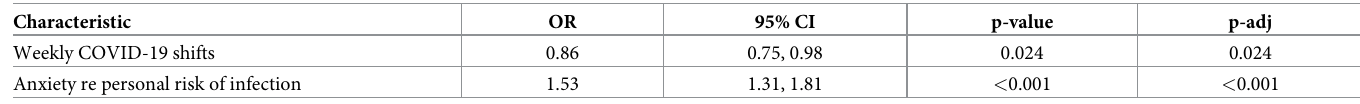
Table 2. Results of multivariate logistic regression analysis of factors predicting clinically-relevant psychosocial distress (GHQ-12 � 3). Characteristic OR 95% CI p-value p-adj Weekly COVID-19 shifts 0.86 0.75, 0.98 0.024 0.024 Anxiety re personal risk of infection 1.53 1.31, 1.81 < 0.001 < 0.001 OR = odds ratio, CI = confidence interval, p-adj = p-value adjusted for multiple